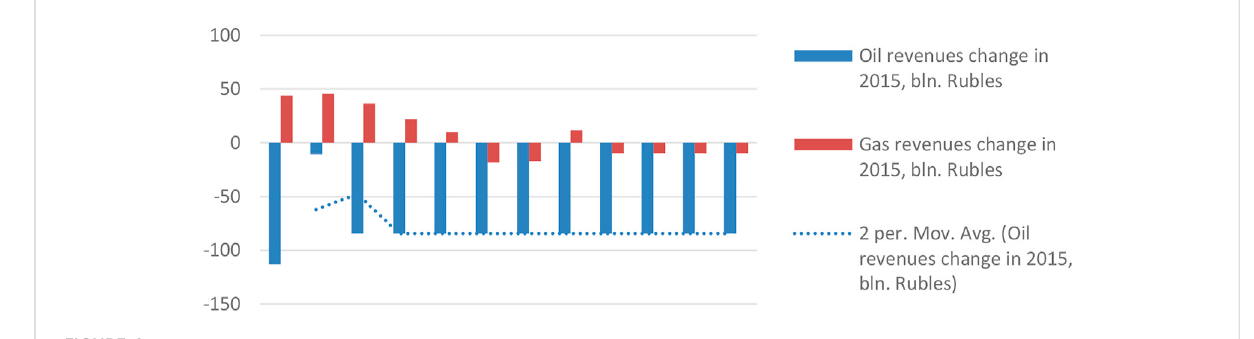
FIGURE 4 Revenue change in 2015, bln Russian